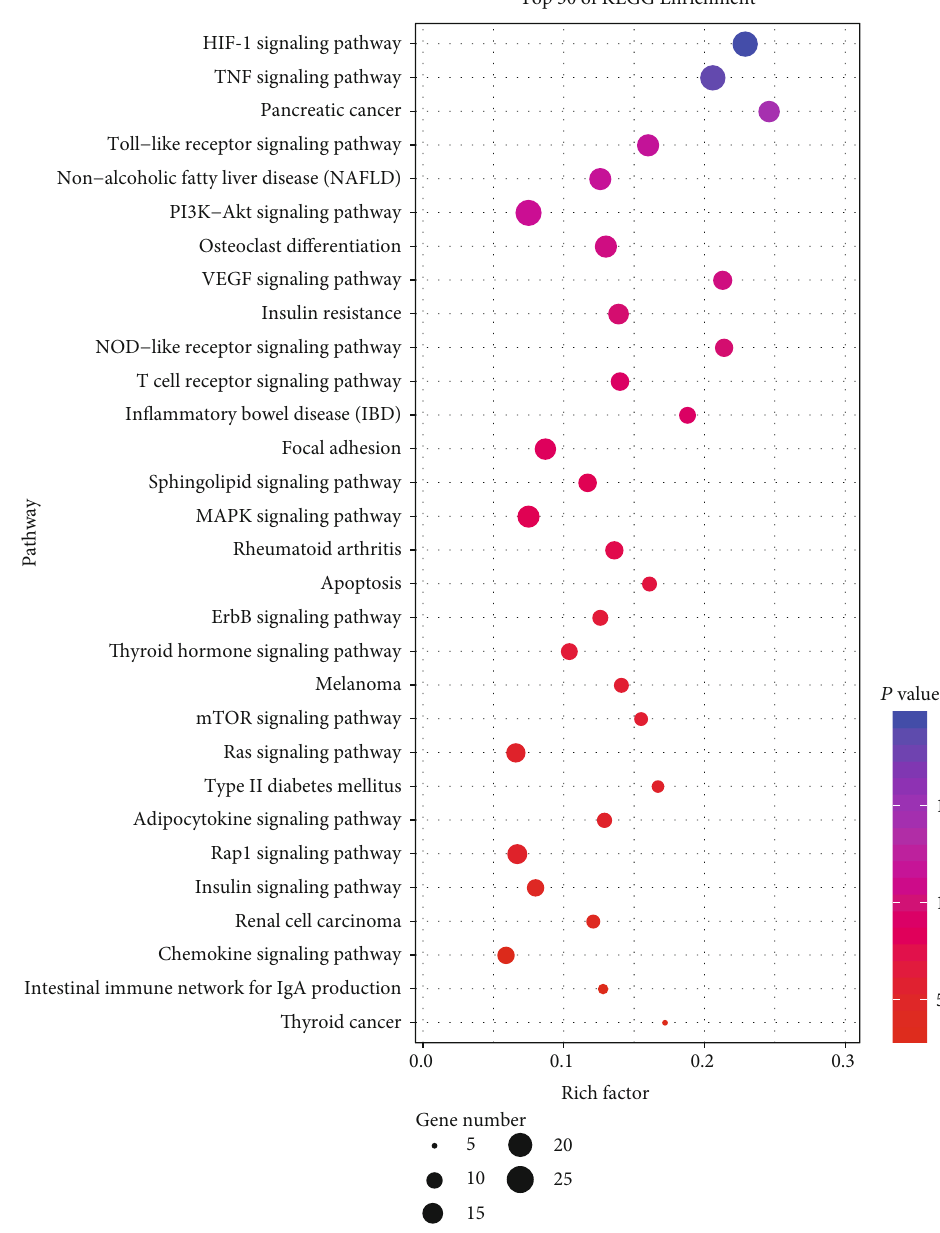
P value, the size of the circle means the gene number, 10